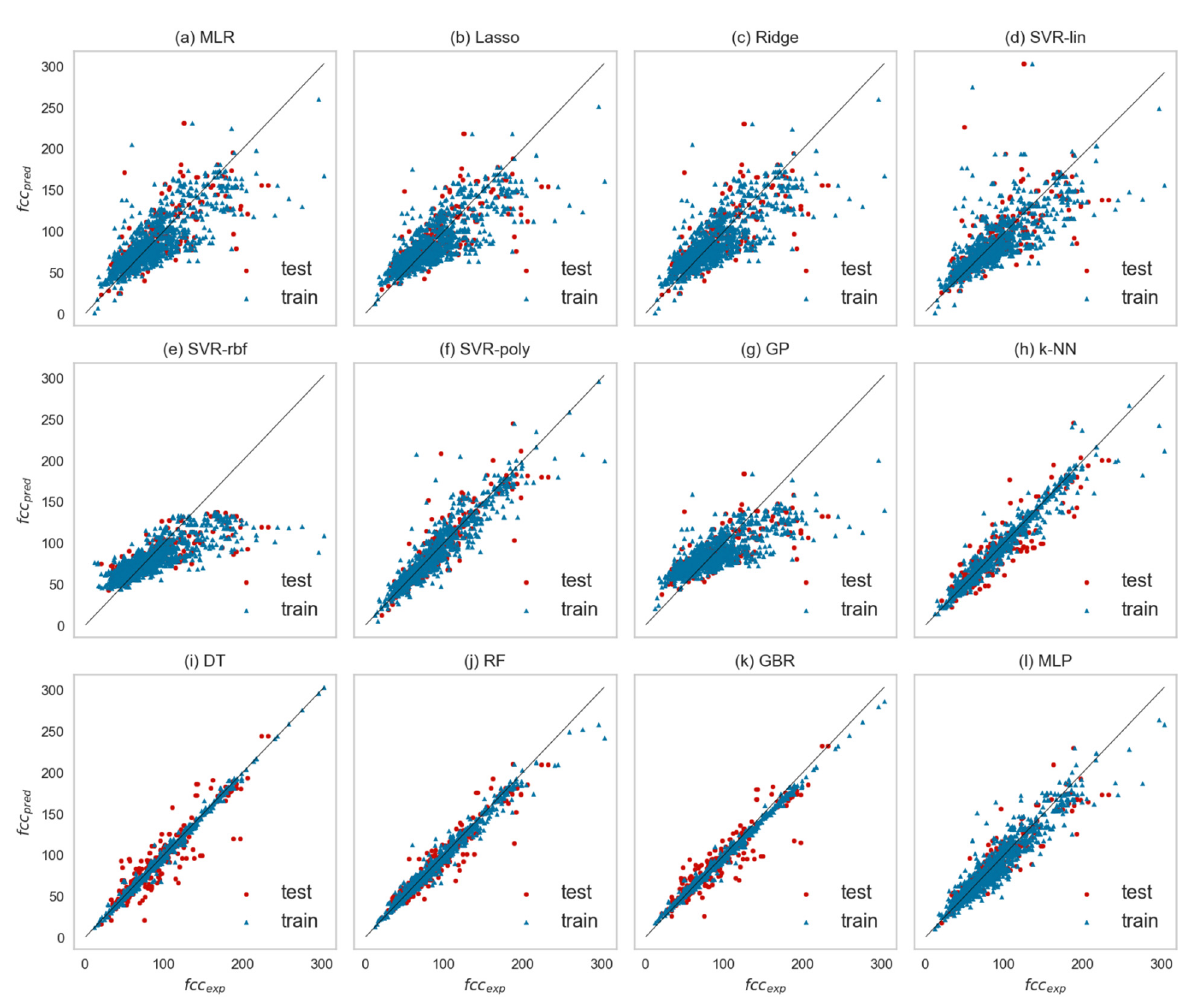
Figure 5. Experimental versus predicted values for f cc (both training and test data) in identity plots being the output of 12 different algorithms, ( a ) MLR, ( b ) LASSO, ( c ) Ridge, ( d ) SVR-linear kernel, ( e ) SVR-RBF, ( f ) SVR-polynomial, ( g ) GP, ( h ) k-NN, ( i ) DT, ( j ) RF, ( k ) GBR, and ( l ) MMLP. The 45° line shows the perfect match.